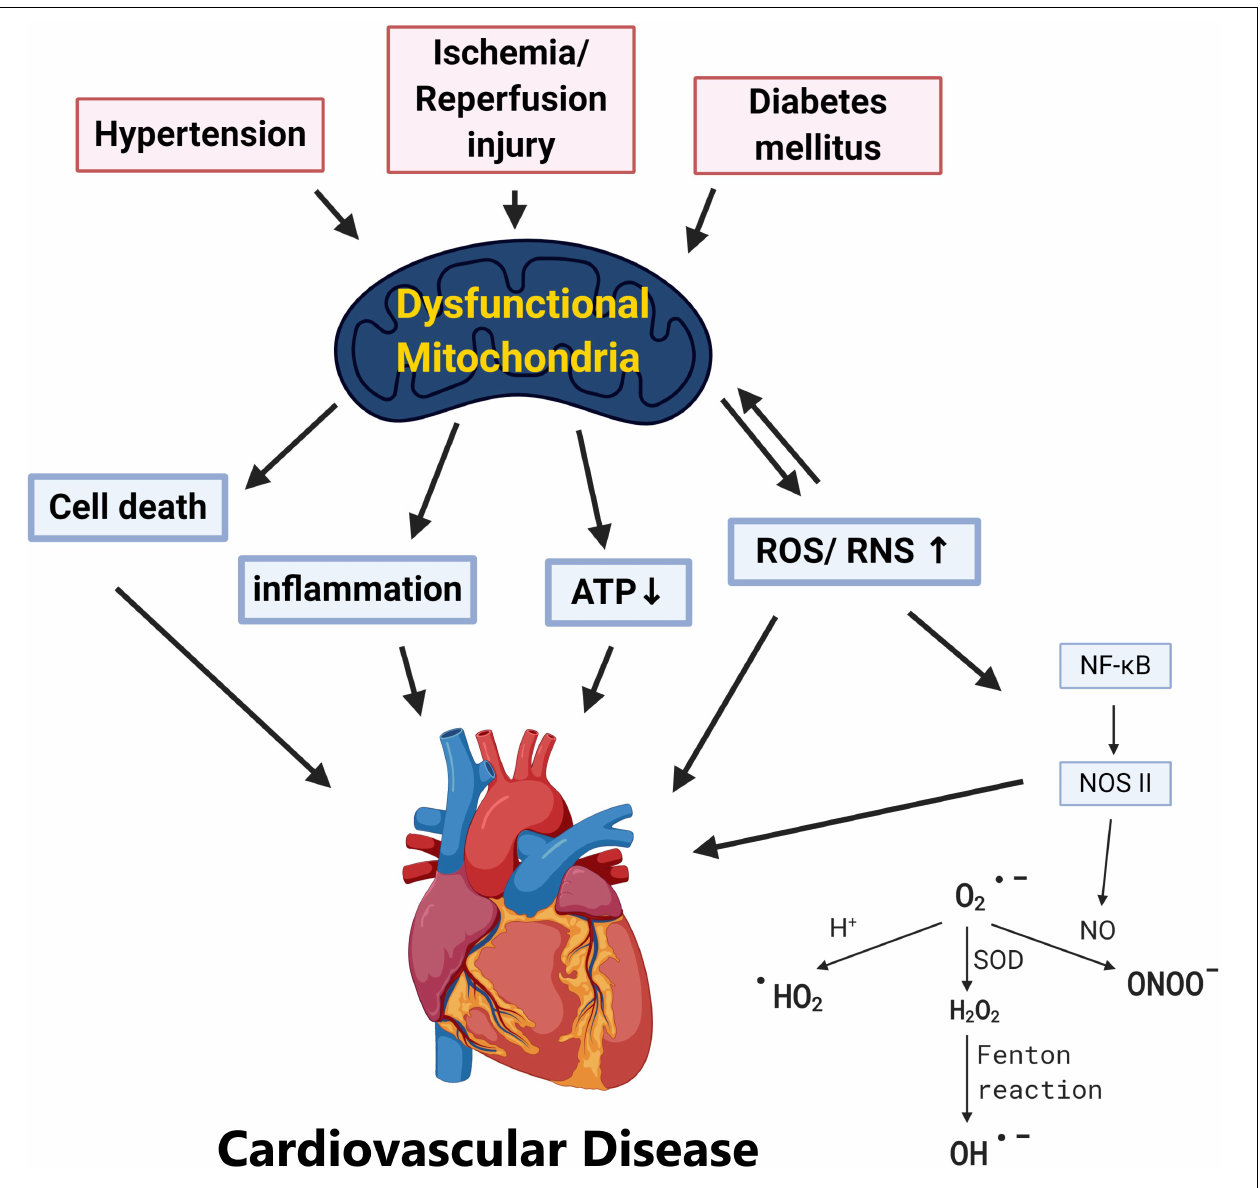
FIGURE 1 | Pathological stress including hypertension, ischemia/reperfusion, and diabetes mellitus results in dysfunctional mitochondria. Various cardiovascular risk factors including hypertension, ischemia/reperfusion injury, and diabetes leads to mitochondrial dysfunction. Without adequate quality control of the damaged mitochondria, this may result in (1) ATP depletion, (2) overproduction of ROS/RNS, (3) mitochondria-dependent cell death (apoptosis), and (4) systemic inflammation which provokes cardiovascular